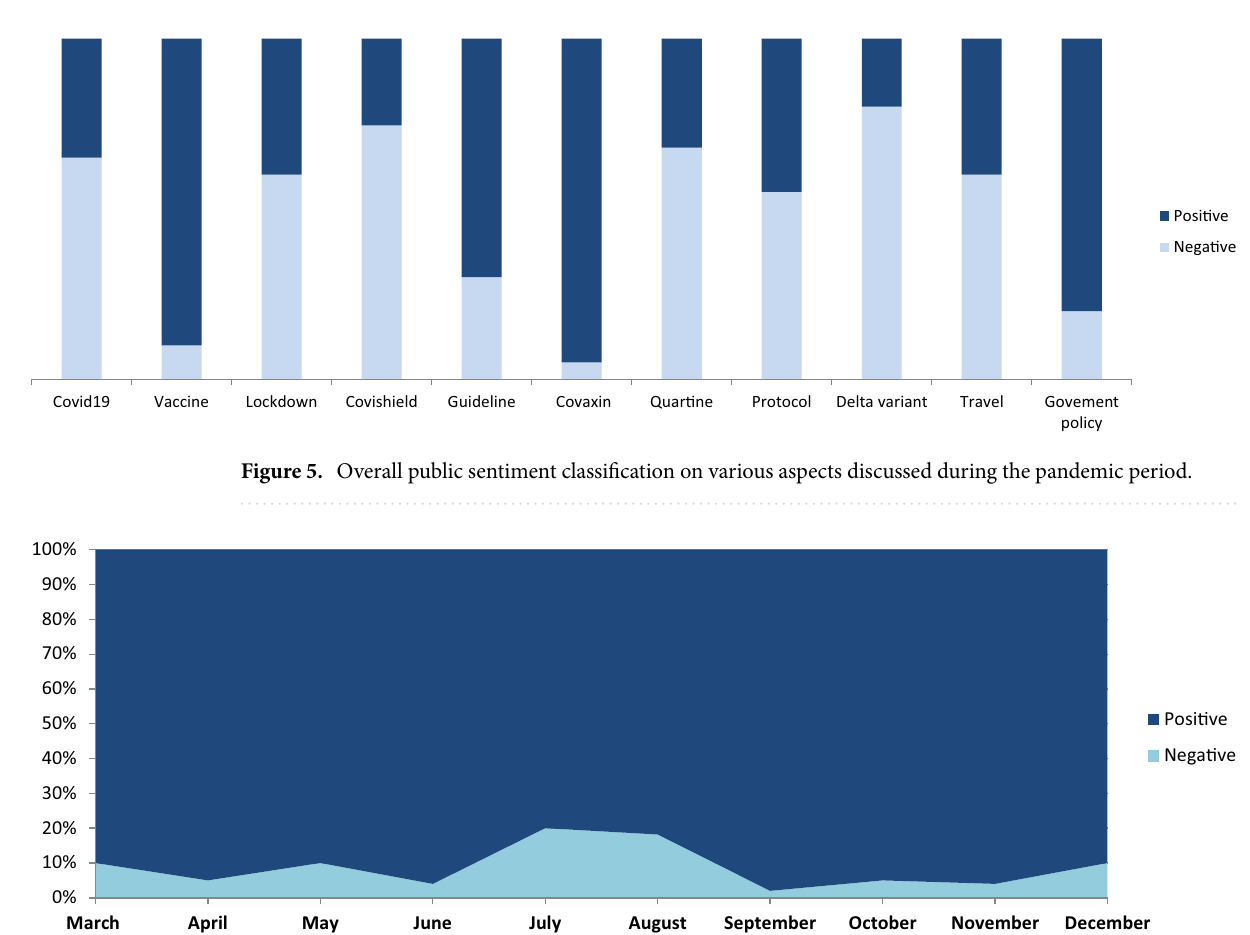
Figure 4. The proposed method comparative result analysis monthly reported during pandemic a period.